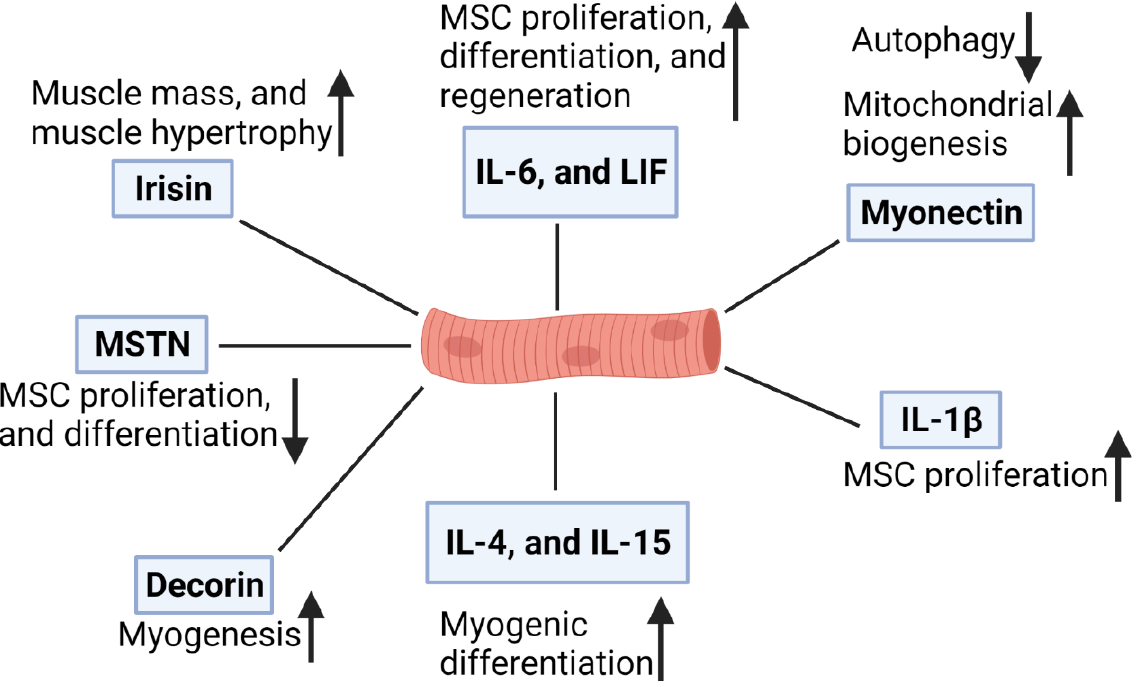
Figure 1. Function of myokines in skeletal muscle.